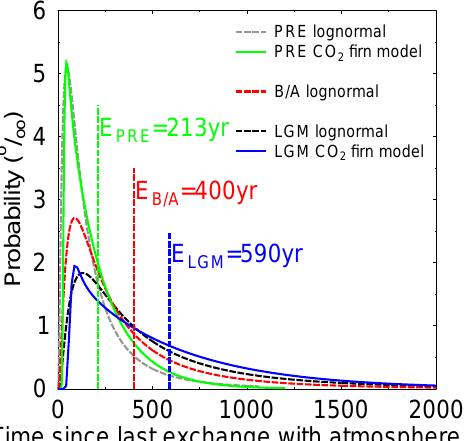
Fig. 2. Age distribution PDF of CO 2 as a function of climate state, here pre-industrial (PRE), Bølling/Allerød (B/A) and LGM condi- tions. Calculation with a firn densification model (Joos and Spahni, 2008) (solid lines, for PRE and LGM) and approximations of all three climate states by a log-normal function (broken lines). For all functions the expected mean values, or width E , are also